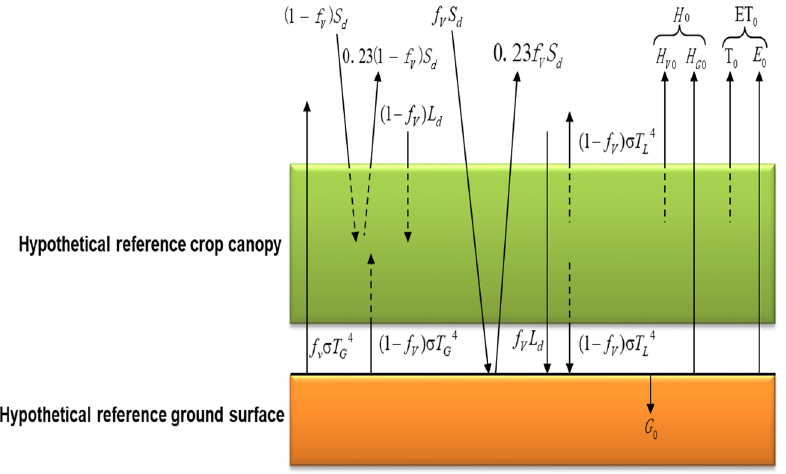
Figure 1. An updated reference: soil-plant-atmosphere continuum (R-SPAC) model for estimating reference evapotranspiration and its components, updated from Wang and Yamanaka, 2014 [28]. All symbols used are defined in the text.